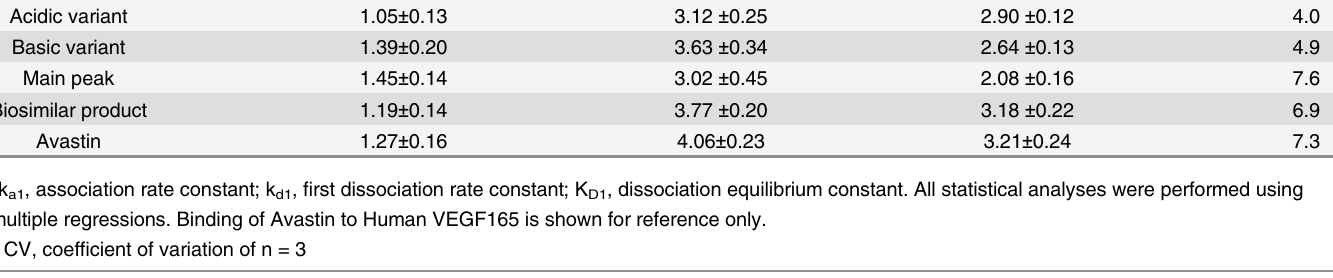
Table 2. Kinetics constants of the isolated charge variants, the biosimilar product and Avastin (mean ± standard deviation, n = 3). Test